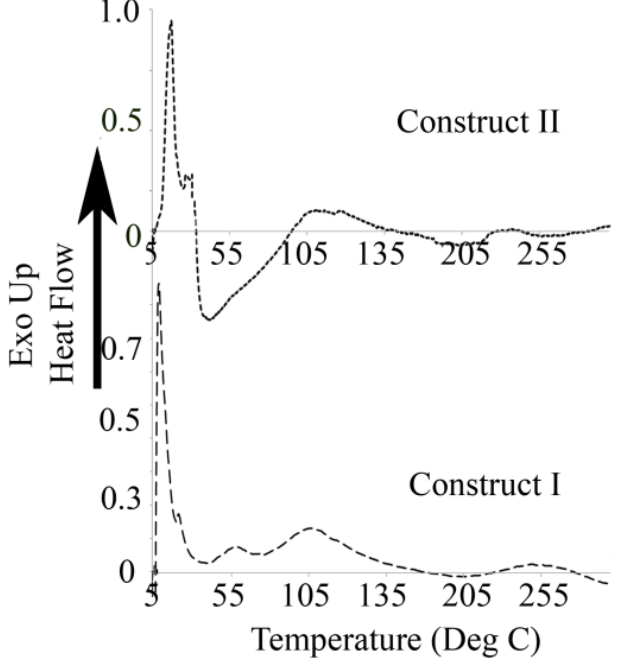
Figure 5. Comparison of DSC thermograms of Construct I and Construct